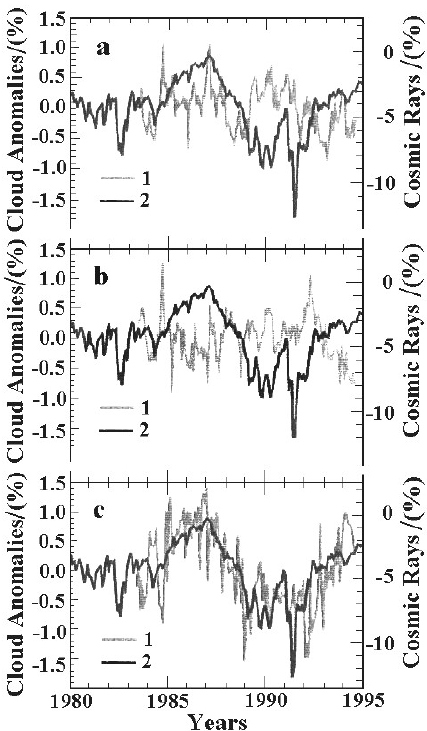
Fig. 3. CR intensity obtained at the Huancayo/Haleakala neutron monitor (normalized to October 1965, curve 2) in comparison with global average monthly cloud coverage anomalies (curves 1) at heights, H , for: (a) – high clouds, H > 6 . 5km, (b) – middle clouds, 6.5km >H > 3.2km, and (c) – low clouds, H < 3 . 2km. According to Marsh and Svensmark (2000).